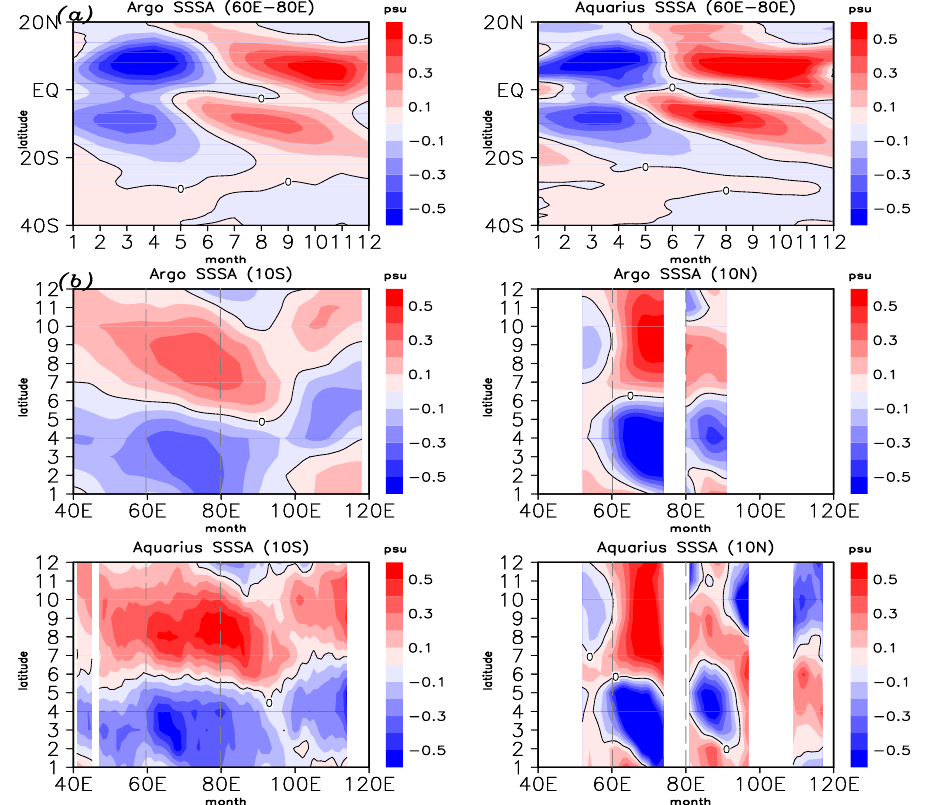
Figure 2. Time-latitude diagrams ( a ) of SSSAs between 60° E and 80° E and hovmöller diagrams ( b ) of SSSAs along the area of 10 ° S and 10 ° N in Argo and Aquarius (Unit: psu, the dashed lines enclose the SSSAs ESF areas).